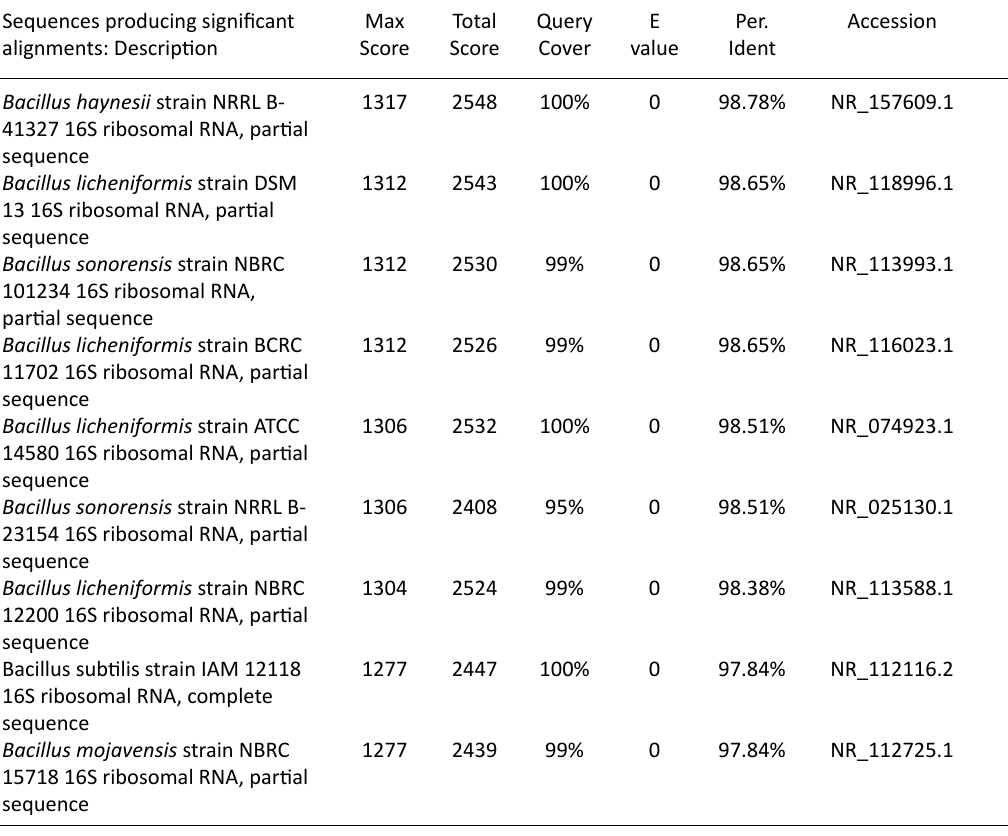
Table 2. Results obtained after the BLAST analysis of sample SOSS_7_4 Sequences producing significant Max Total Query E Per.